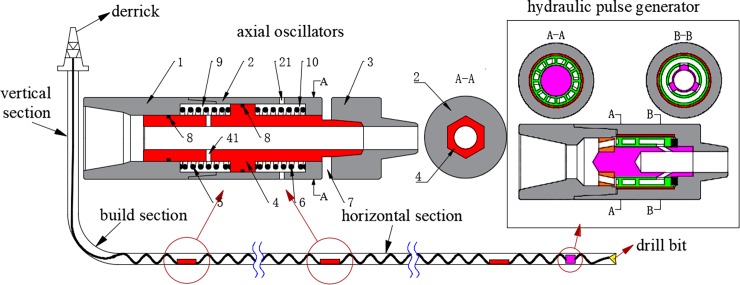
Schematic diagram of earthworm-like drilling.Parts of shakers: 1-upper sub; 2-sleeve; 21- low-pressure hole; 3-lower sub; 4- center shaft; 41-high-pressure hole; 5,6-disc spring; 7- moving clearance; 8-seal; 9-high-pressure chamber; 10-low-pressure chamber https://dx.doi.org/10.17504/protocols.io.kezctf6.